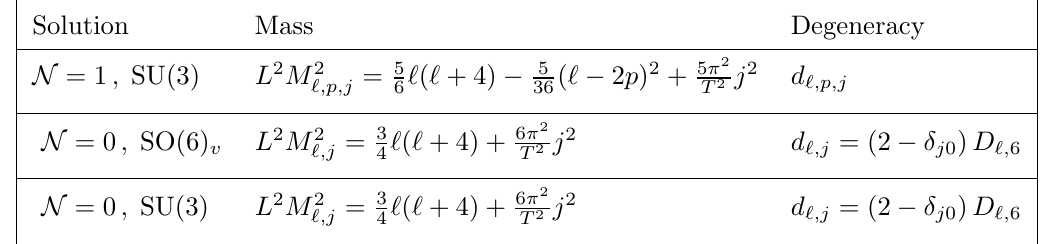
Table 4 . The KK graviton spectra of AdS 4 S-fold solutions of type IIB supergravity that uplift (cid:0) (cid:1) n R 12 from critical points of D = 4 N = 8 SO(6) (cid:2) SO(1 ; 1) -gauged supergravity with at least SU(3) symmetry. See (2.20) for the notation D k;N and (2.40) for d ‘;p;j . The quantum numbers range as in